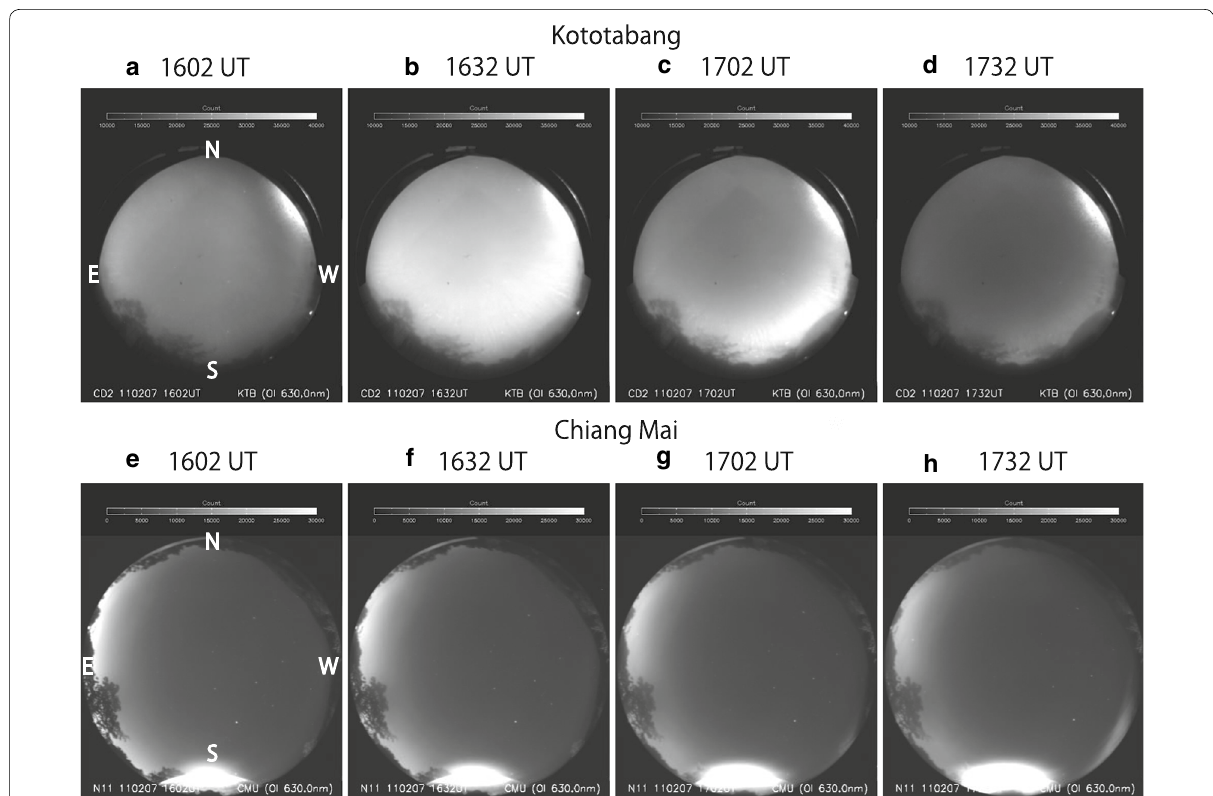
Fig. 2 All-sky images obtained by airglow imagers at a – d Kototabang and e – h Chiang Mai from 1602 to 1732 UT on February 7, 2011. Up is geo- graphic north and left is geographic east in each image